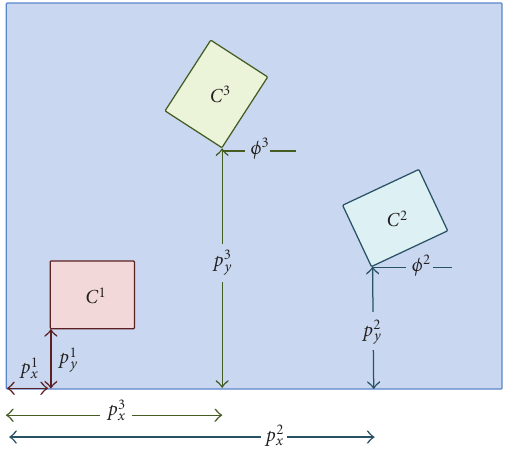
Figure 2: Schematic representation of a scene observed with Figure 4: Example of sharp turns modeled with smooth curves in , p i , φ i ) represent the unknown nonoverlapping cameras ( C i ). ( p i the unobserved regions ( gray : original trajectory, green : estimated x y camera location and rotation to be estimated. trajectory, gray square : original camera location (field of view), and yellow square : estimated camera location (field of